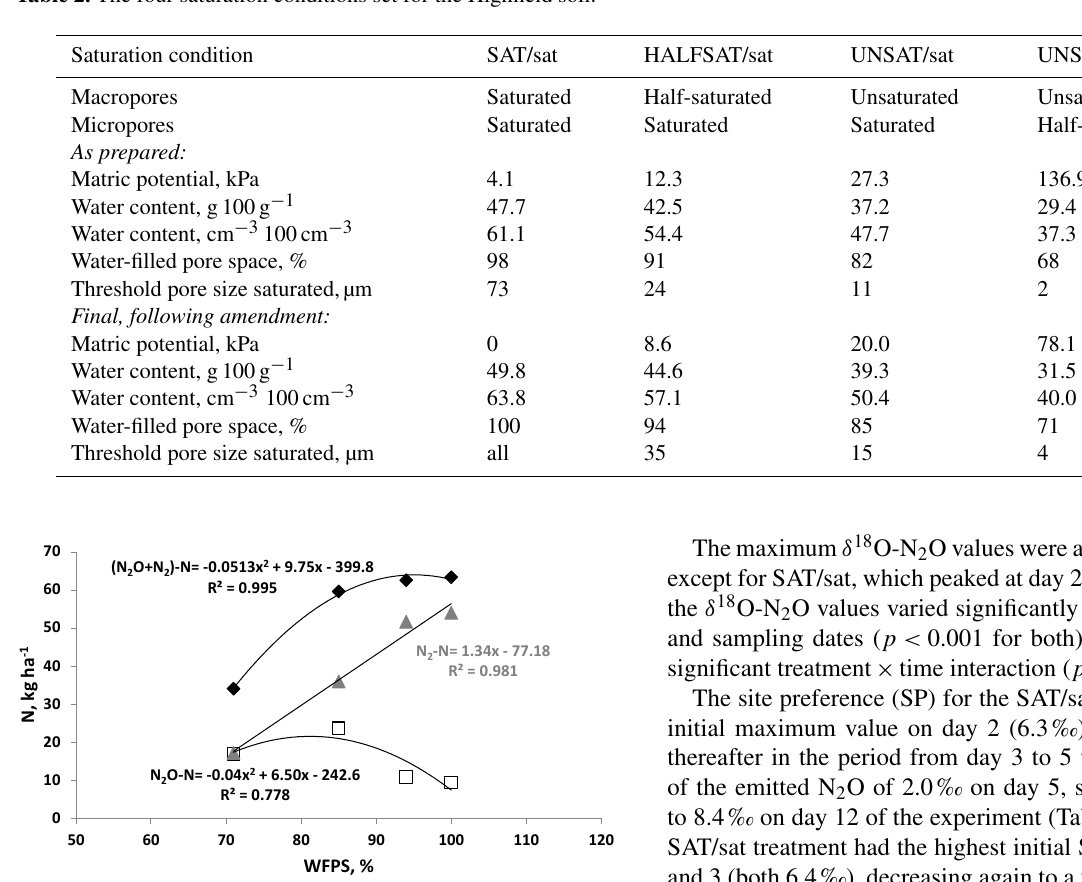
Table 2. The four saturation conditions set for the Highfield soil.